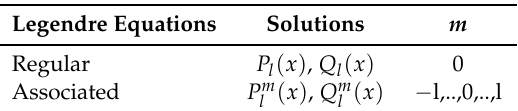
Table 3. The linearly independent solutions of the regular and associated Legendre